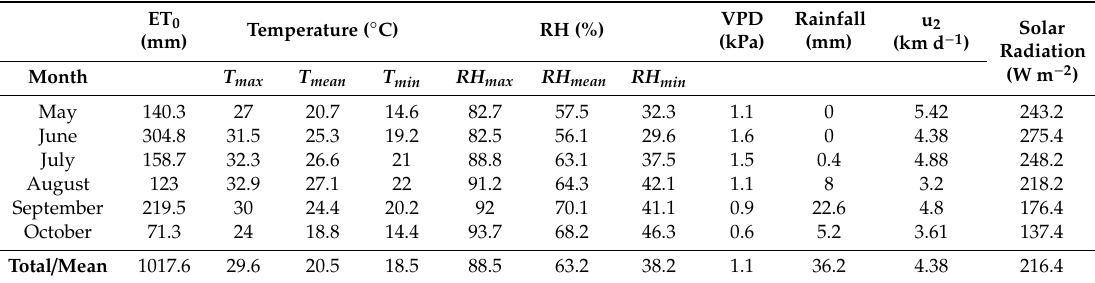
Table 1. Monthly values of total crop reference evapotranspiration (ET 0 ), maximum, mean, and minimum air temperatures (T max , T mean , and T min ), maximum, mean, and minimum relative humidity (RH max , RH mean , and RH min ), mean vapor pressure deficit (VPD), total rainfall, and mean wind speed at 2 m (u 2 ) and solar